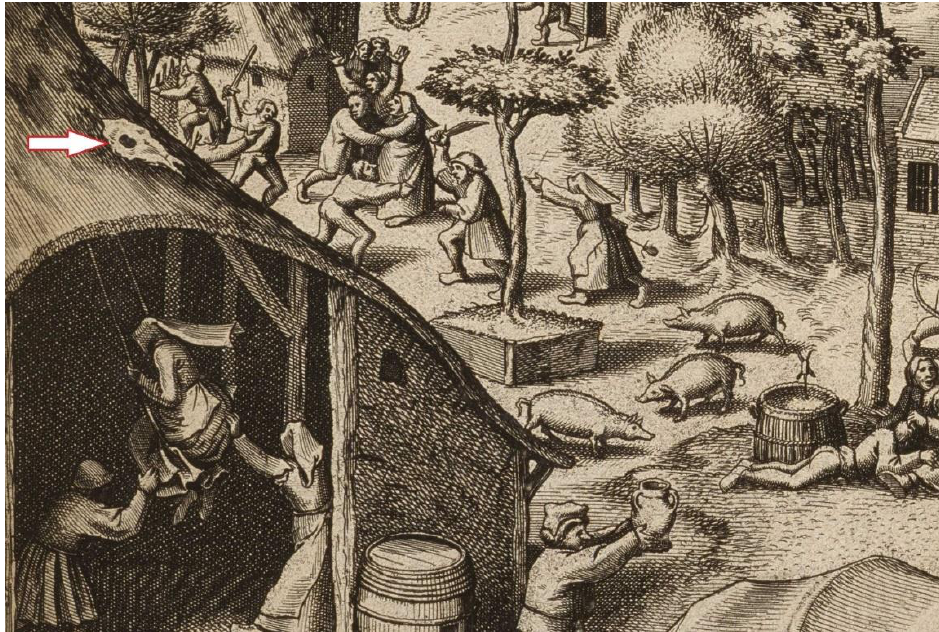
Figure 5. Skull of a horse on the roof of the building. St. George’s Day, painting by P. Bruegel (the part of the painting by https://upload.wikimedia.org/wikipedia/commons/3/31/Pieter_Bruegel_the_Elder_-_The_Fair_of_Saint_George%27s_Day_-_Google_Art_Project.jpg, accessed date on 5 April 2022).